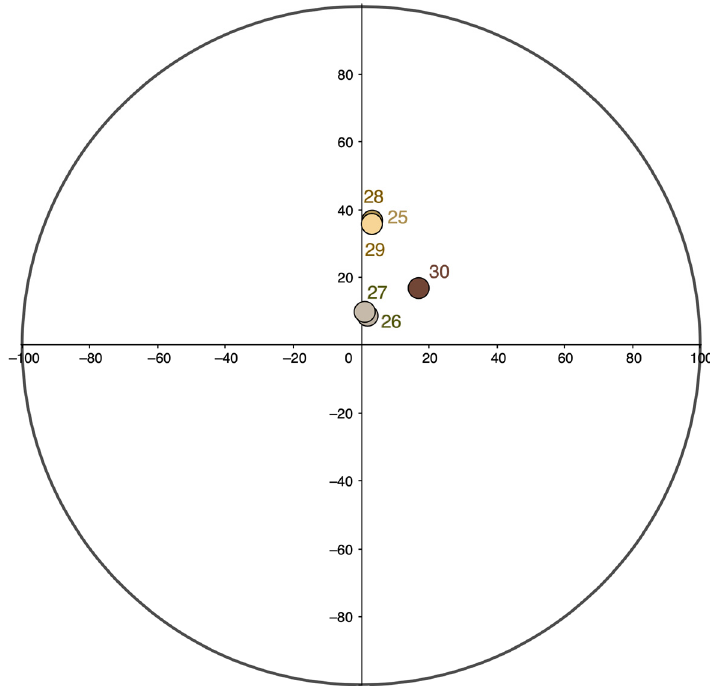
Figure 6. Hue (h°) and chroma (C) of the main colors from Section IV; projection into the CIELCh color circle.